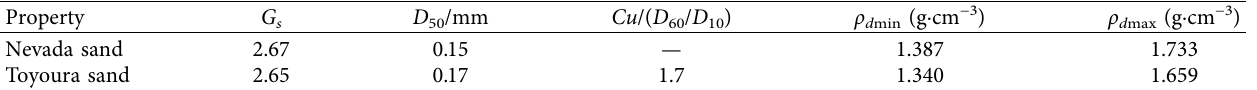
Figure 6: Stress-strain curve of saturated calcareous sand at drained compression. Tests on specimens (a) with different relative densities and (b) at different confining Table 3: Physical properties of Nevada sand and Toyoura sand.